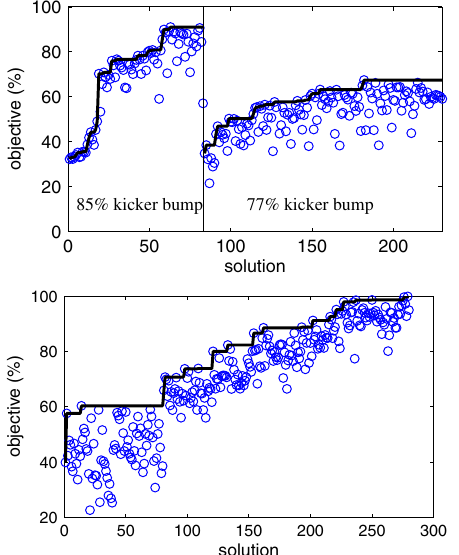
FIG. 2. Comparison of sextupole settings for the original and optimized